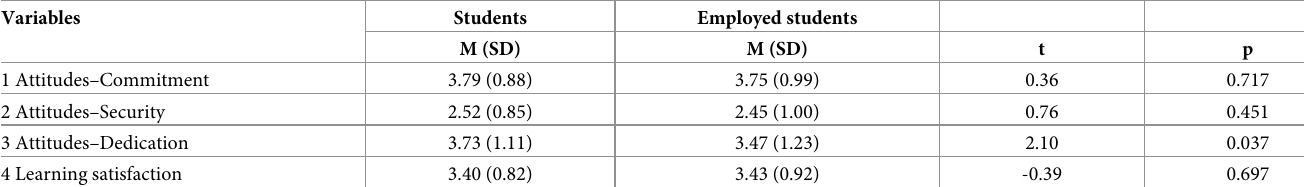
Table 5. Differences in the studied variables according to nursing students’ work experience in health care.